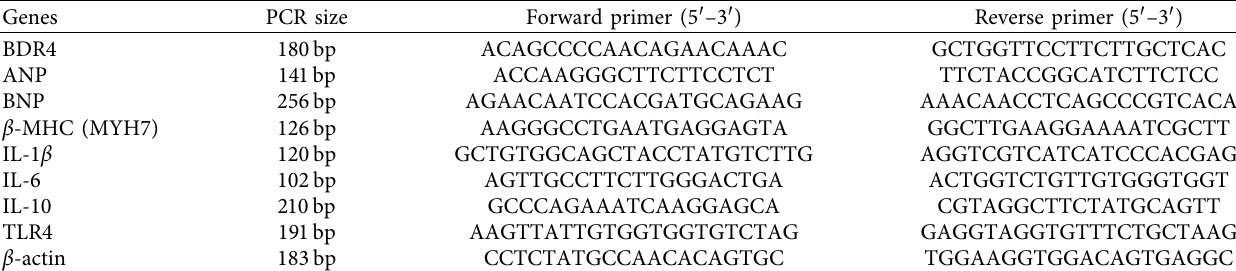
Table 1: List of oligonucleotide primer sequences used in this